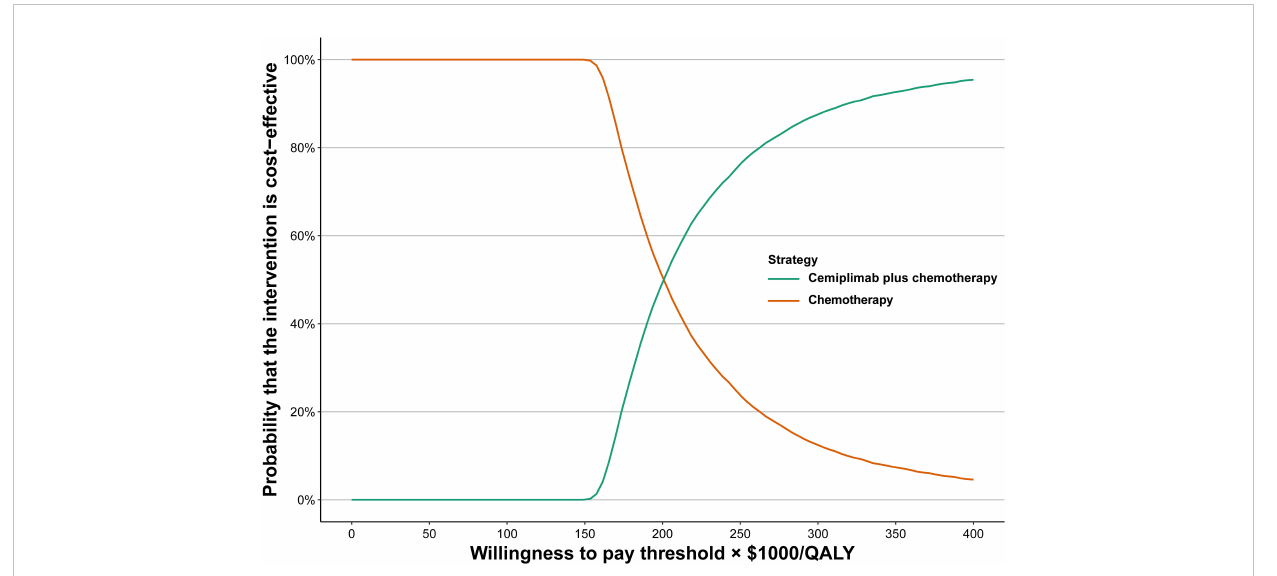
FIGURE 2 Acceptability curves of cost-effectiveness for cemiplimab plus chemotherapy versus